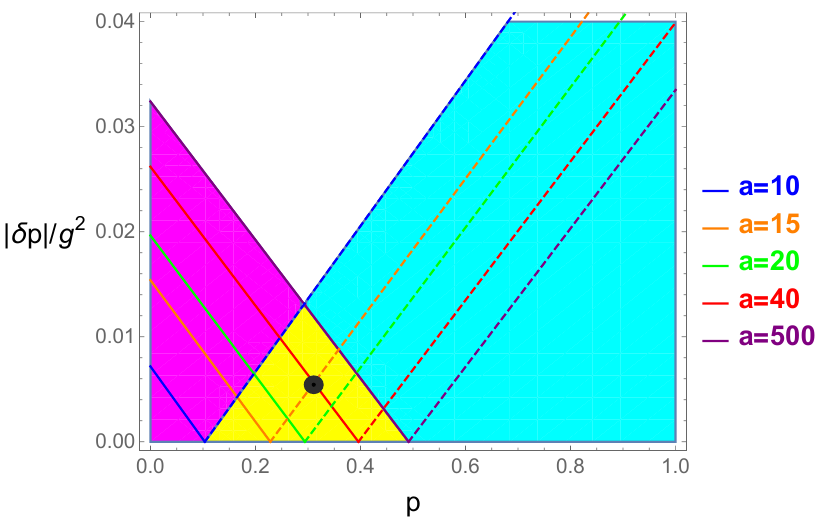
Figure 7. This plot shows the behavior of the absolute value of the correction j (cid:14)p j as function of p , for various reduced accelerations a = (cid:11)=! and velocity v = 0 : 8. Continuous lines contain points representing positive corrections, with the vacuum behaving as a hot thermal bath. Dashed lines show negative corrections, with the vacuum acting as a cold thermal bath. For the magenta region, the vacuum only acts as a hot reservoir. For the cyan region, the vacuum only acts as a cold reservoir. In the yellow region, we show that the cycle can be closed, since the vacuum acts either as hot or cold reservoir for the same initial value of p , with hot or cold depending on the di(cid:11)erent reduced accelerations associated with the trajectory. The black point intersection de(cid:12)nes a triplet ( a H , a C , p) for which we can de(cid:12)ne a closed